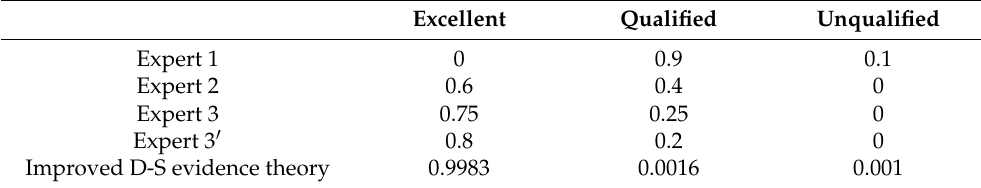
Table 7. Basic probability